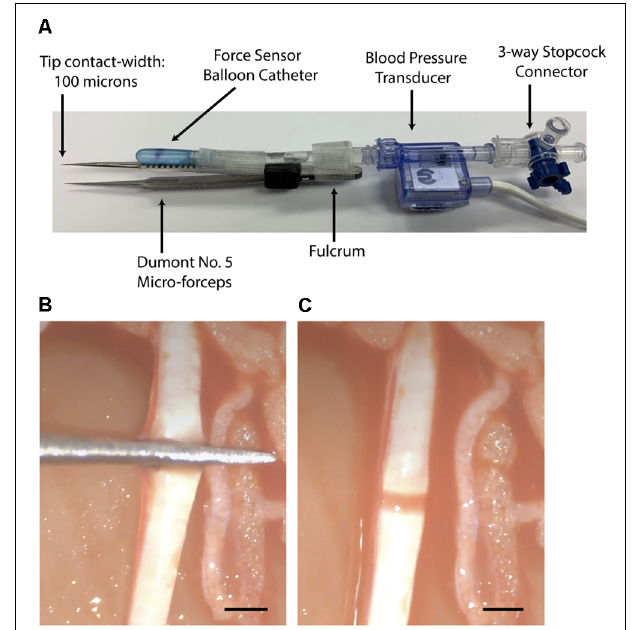
FIGURE 4 | (A) Dumont No. 5 micro-forceps and interface shown. (B) View of the tibial nerve during crushing with the instrumented micro-forceps. (C) View of the nerve crush lesion ∼ 5 sec after crush giving a narrow and translucent appearance. Bars = 1 mm.